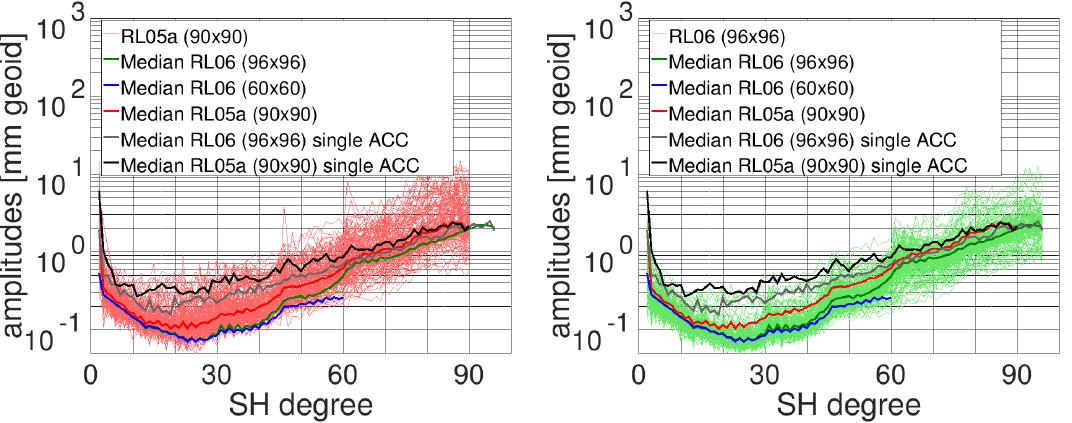
Figure 4. Degree amplitudes relative to a climatology model for GFZ RL05a ( left ) and GFZ RL06 ( right ); thin lines represent monthly solutions (without “GRACE single ACC” solutions and those regularized in RL05a), and bold lines represent the median curves (the same curves are shown in both plots) for RL05a (red), RL06 (96 × 96, green), RL06 (60 × 60, blue), and the “GRACE single ACC” months only for RL05a (black) and RL06 (96 × 96,